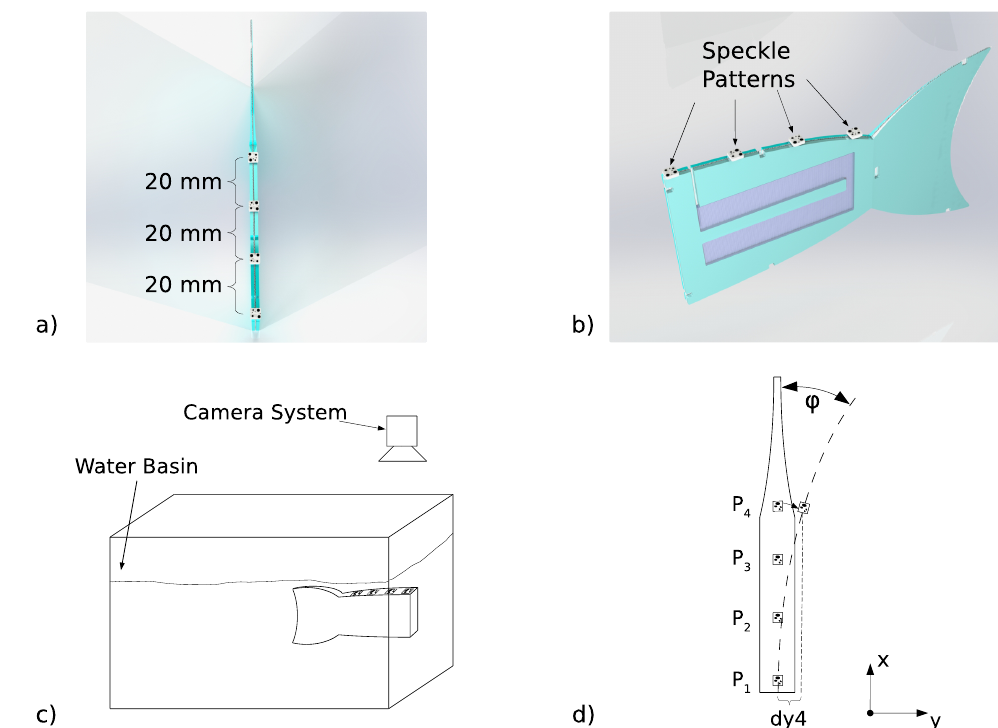
Figure 5. Fish fin robot with speckle patterns for deflection measurements using digital image correlation. ( a ) Top view with distances of the speckle patterns, ( b ) side view, ( c ) water basin with the mounted robot under water and camera system above, ( d ) top view of the fish fin as seen by the